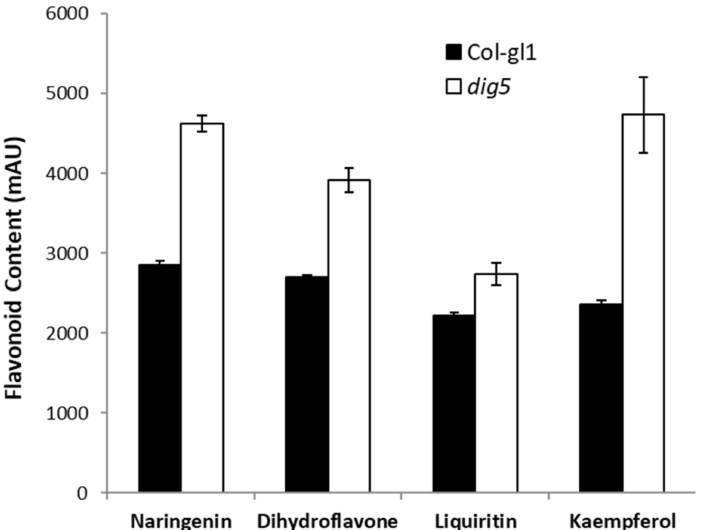
Figure 8. Flavonoid levels in dig5 roots. Flavonoids in roots of 2-week-old dig5 and wild type Col- gl1 seedlings were extracted and quantified with HPLC (mAU, milli Absorbance